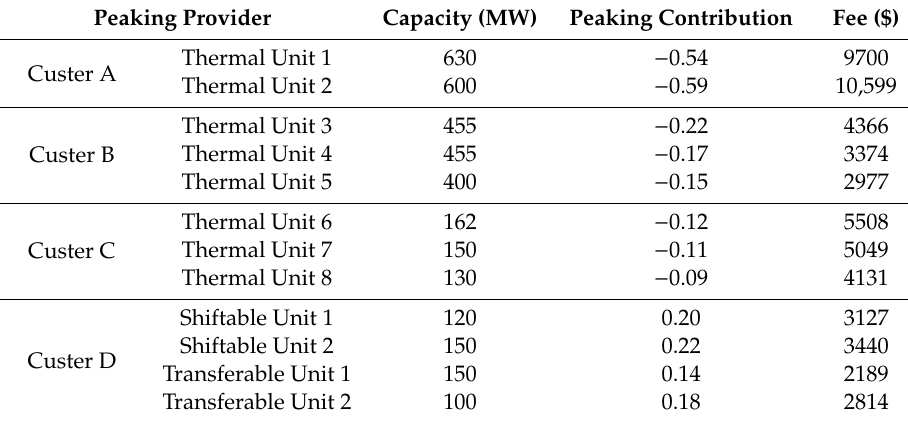
Table 7. Allocation result in inner